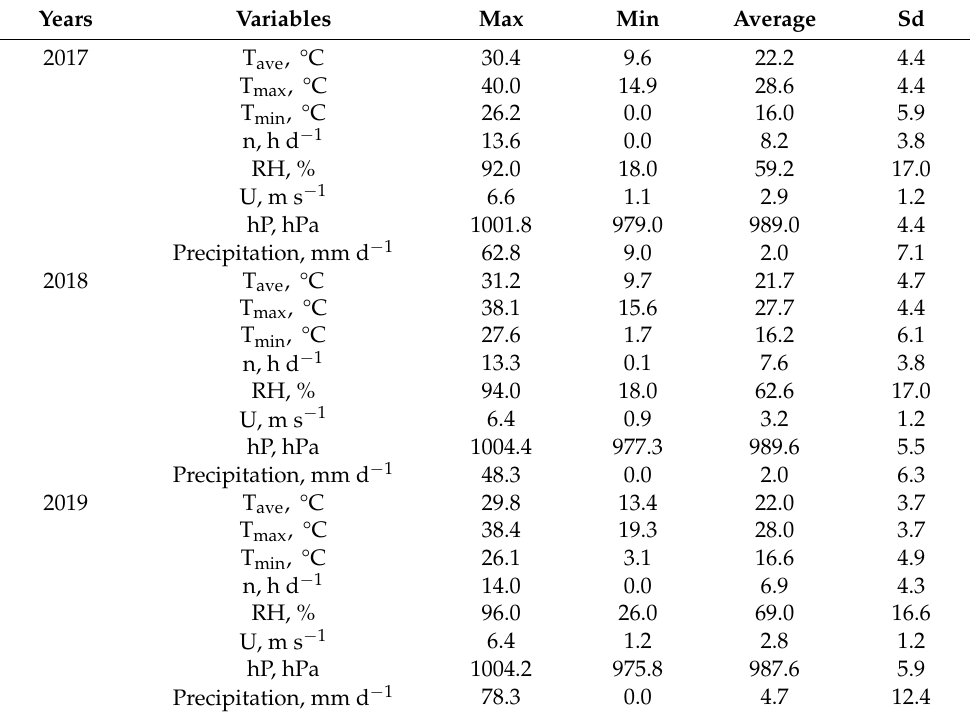
Table 1. Daily meteorological data for the experimental site during the spring maize growth periods from 2017 to 2019. Years Variables Max